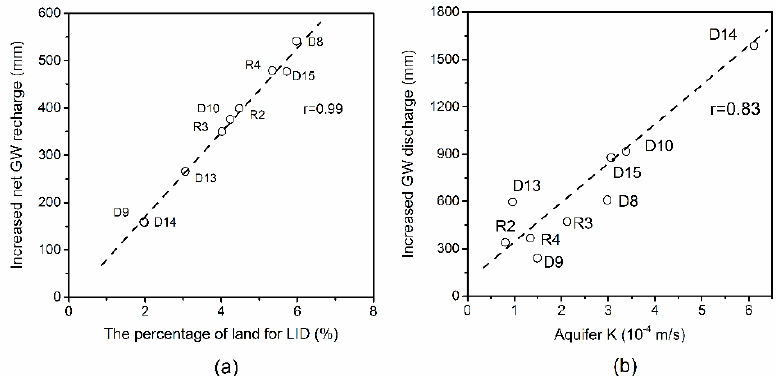
Figure 10. The correlation of the main factors with increased cumulated ( a ) net groundwater recharge and ( b ) discharge.